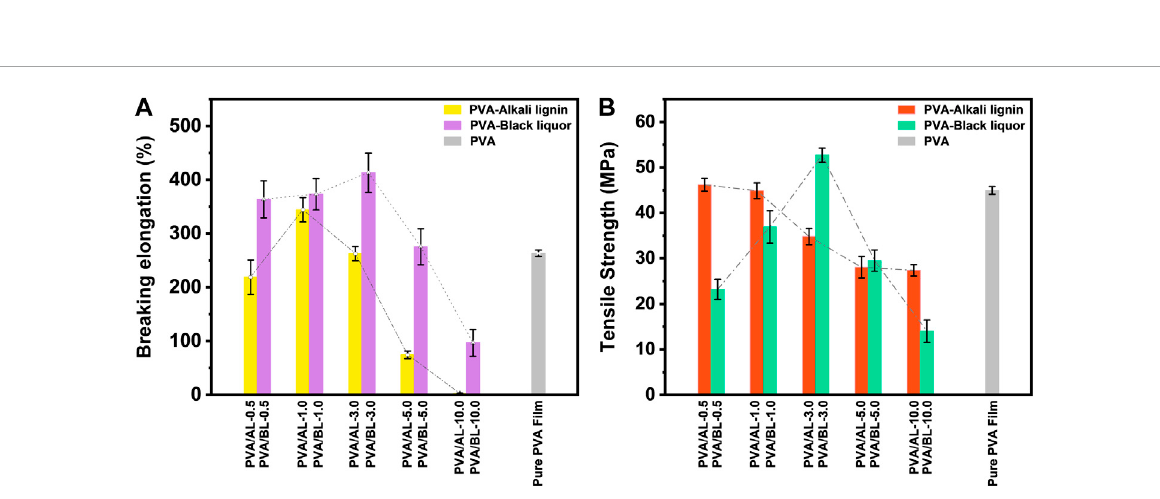
using NanoScope Analysis 1.5. The roughness of the composite fi lm is speci fi ed by the magnitude of the values of Rq and Ra, where Rq represents the root mean square value and Ra represents the average value of the relative datum plane.